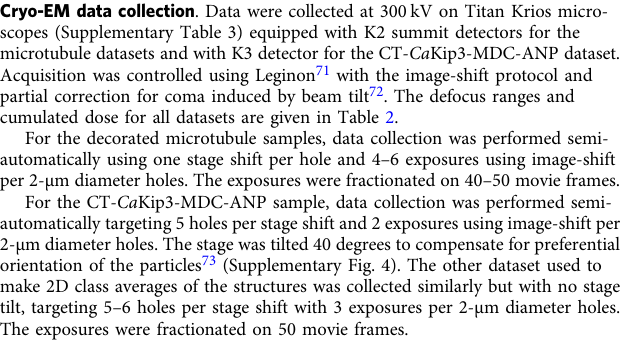
Table 3. The partially signal subtracted dataset was then used in a Relion 3D re fi nement procedure using as priors the Euler angle values determined form the Relion helical re fi nement and the symmetry expansion procedure (initial resolution: 8Å, sigma_ang: 2, offset range corresponding to 3.5Å, healpix_order and auto_local_healpix_order set to 5). The CTF of each particle was corrected to account for their different position along the optical axis. (3) 3D classi fi cation of the kinesin signal. A second partial signal subtraction procedure identical to the fi rst one but using mask kinesin and with particles re-centered on the projections of C M was performed to subtract all but the kinesin signal. The images obtained were resampled to 3.5 Å/pixel and